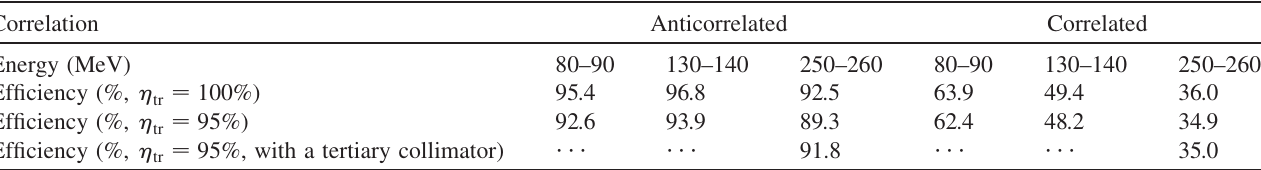
TABLE VI. Overall collimation efficiencies of the momentum collimation system at the CSNS RCS. Correlation